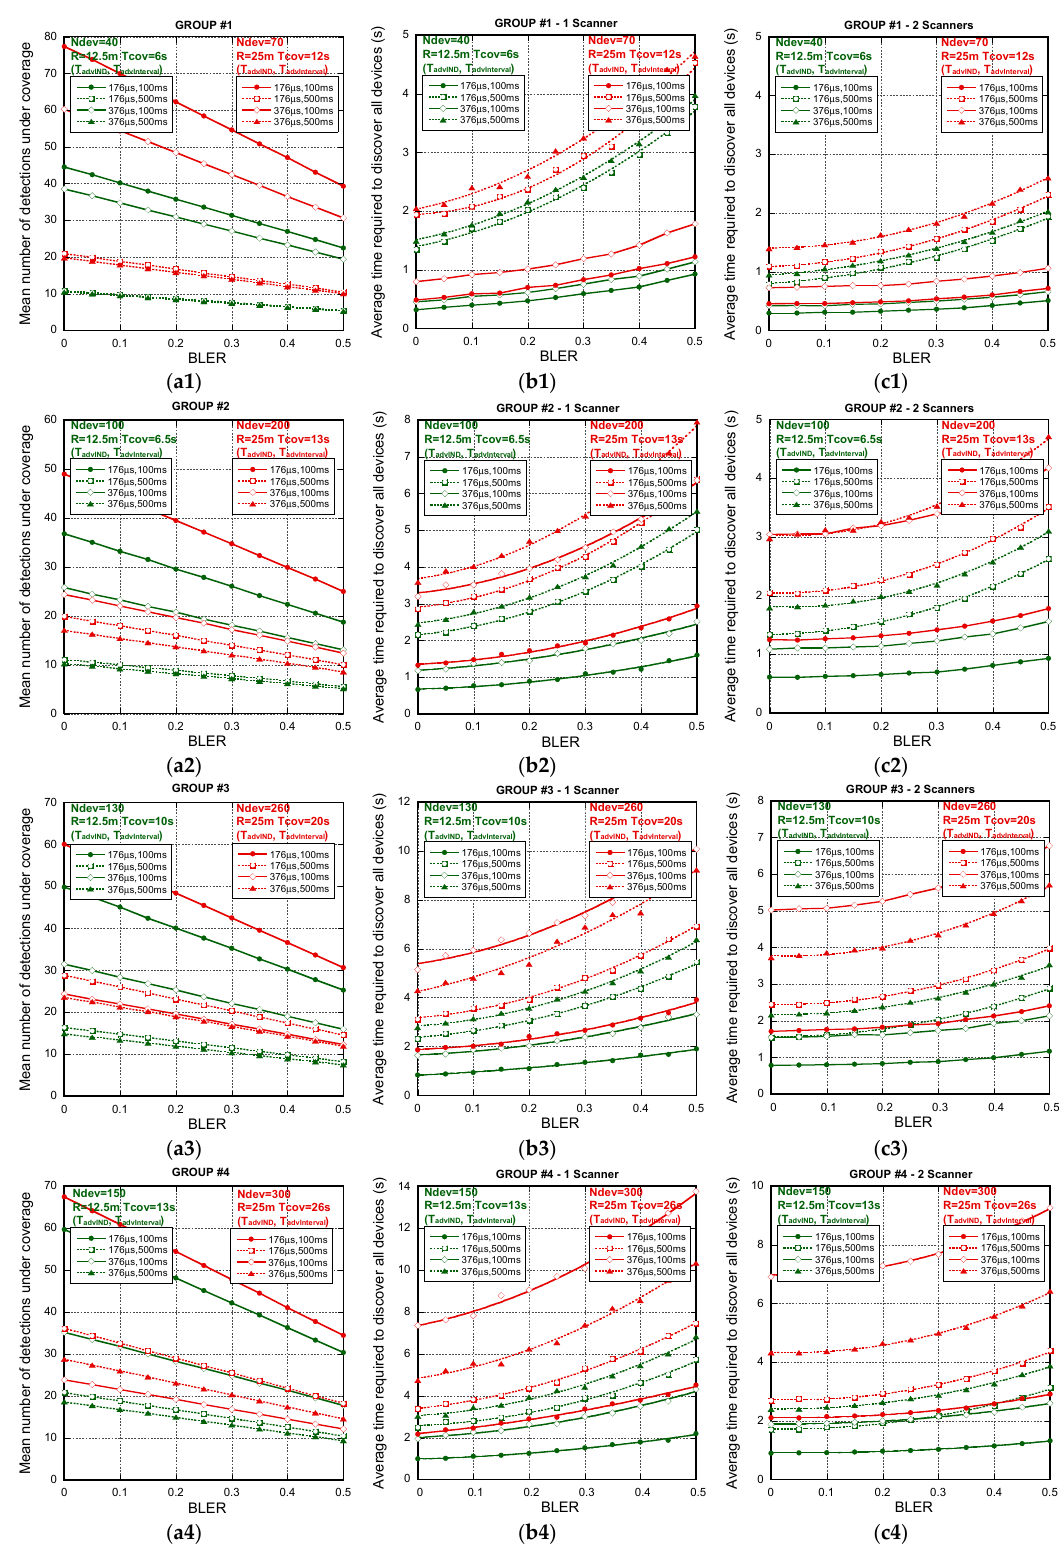
Figure 9. Non-connectable undirected advertisement scheme. Rows (( 1 ) to ( 4 )) represent results for each of the four athlete groups running at different speeds. First column ( a ) represents the mean number of detections under coverage under a single scanner coverage. The second and third columns show the average time required to discover all devices under a single scanner coverage ( b ) and under two scanners ( c ) overlapped coverage, respectively, for several values of BLER, T advIND and T advInterval .